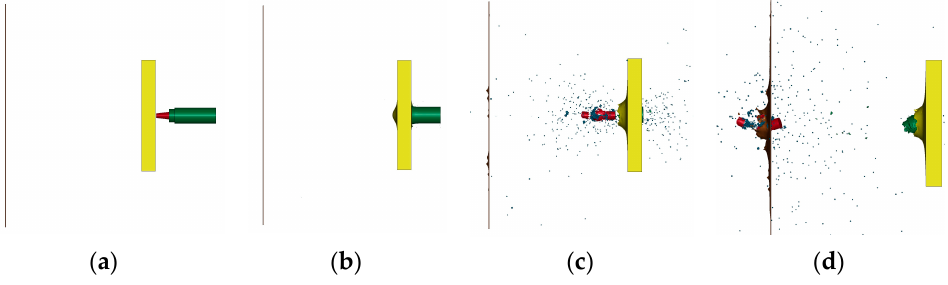
Table 3. Parameters of the ignition growth model.